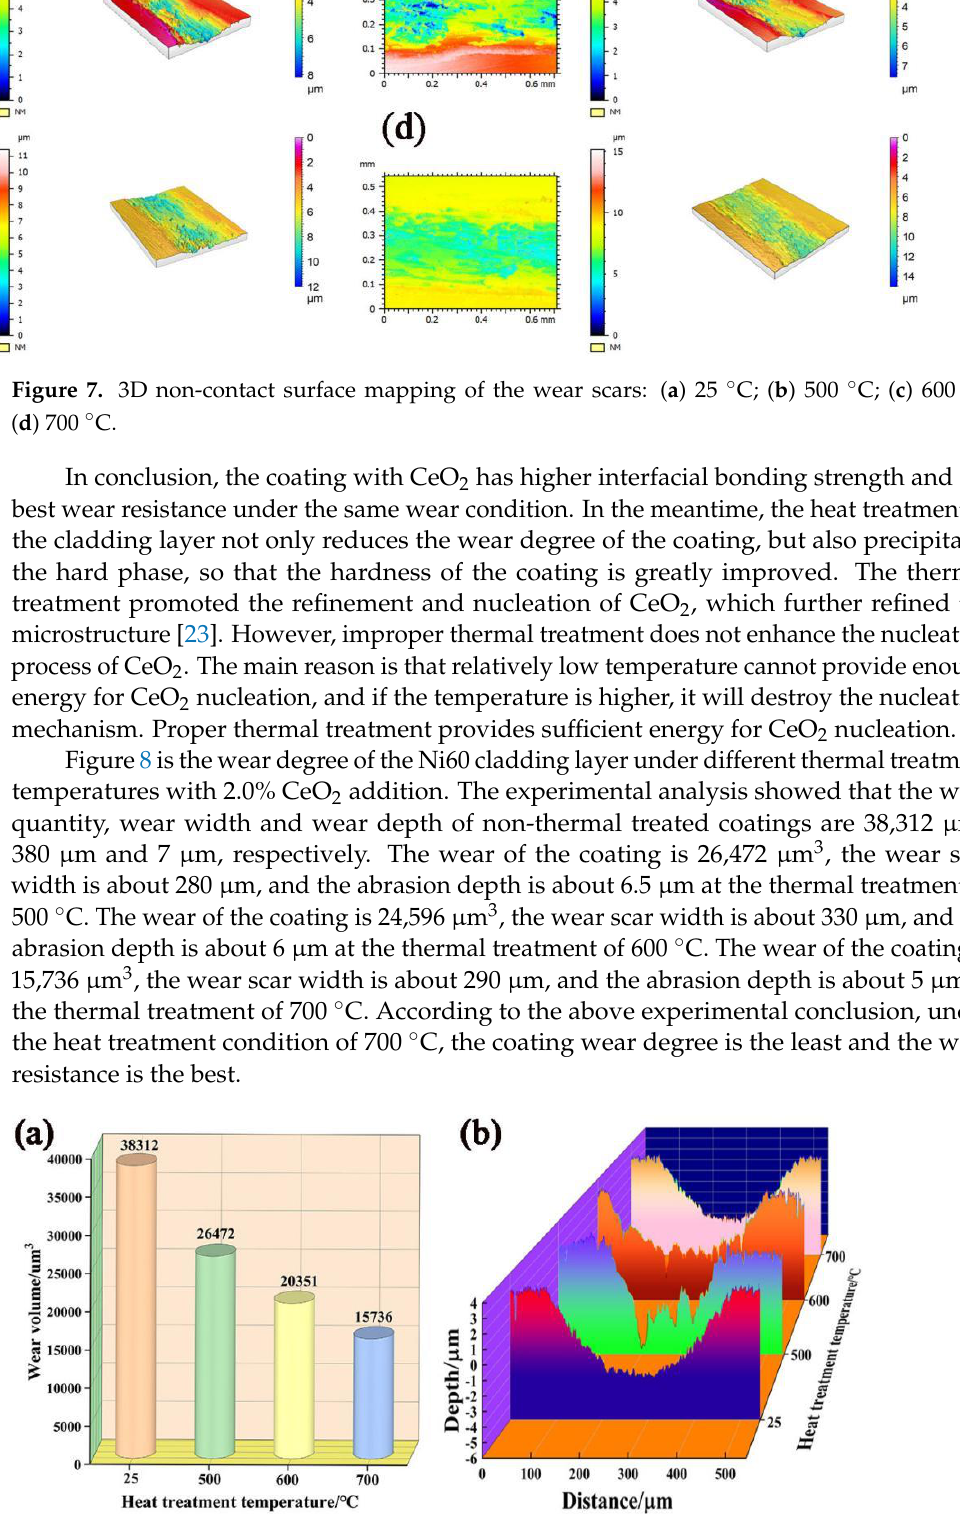
Figure 8. Wear degree of Ni60 cladding layer under different thermal treatment temperatures with 2.0% CeO 2 addition: ( a ) Wear volume; ( b ) Depth of